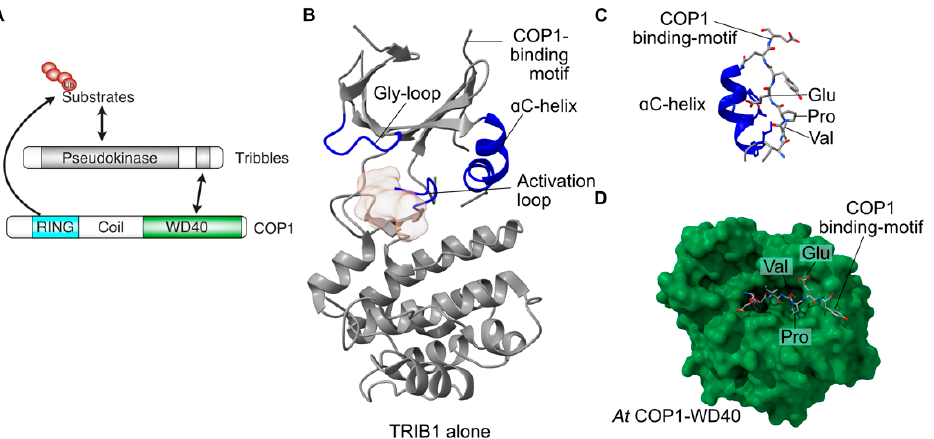
Figure 1. Structure and function of TRIB1. ( A ) Schematic of the predominant role of Tribbles proteins, bringing together substrates and COP1 to promote substrate ubiquitination. ( B ) Structure of autoinhibited TRIB1 (grey; PDB 5cem). Key features are coloured blue and labelled. ( C ) Close-up view of the C-terminal COP1-binding motif binding to the back of the α C-helix in autoinhibited TRIB1. ( D ) Structure of the C-terminal COP1-binding motif bound to the WD40 domain of COP1 (PDB